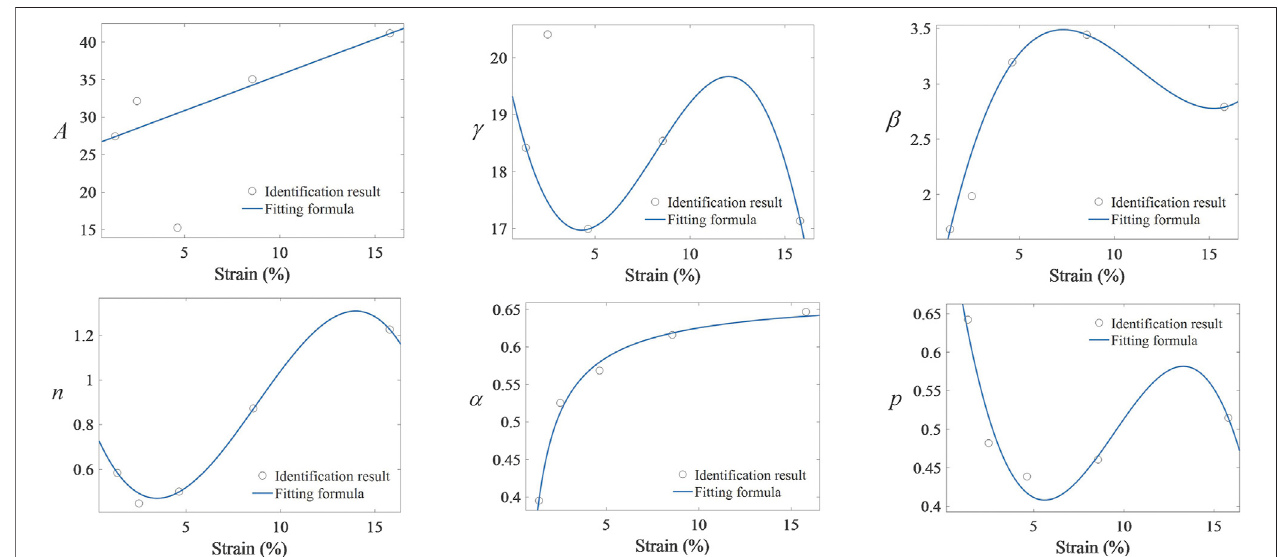
FIGURE 10 | Parameter fi tting curve of modi fi ed Bouc-Wen